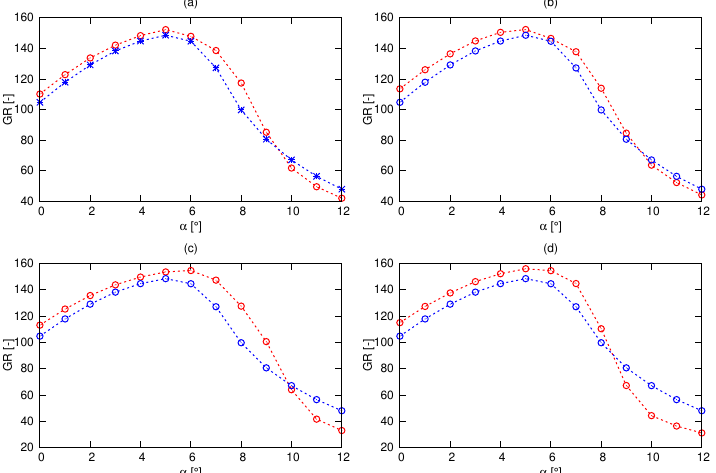
Figure 17. C pmin of the reference and optimized hydrofoils of the second case of 2D optimization, where ( a ) is C pmin of HF-2D-2-1, ( b ) is C pmin of HF-2D-2-2, ( c ) is C pmin of HF-2D-2-3, ( d ) is C pmin of HF-2D-2-4. The red and black lines denote optimized and reference hydrofoil, respectively.